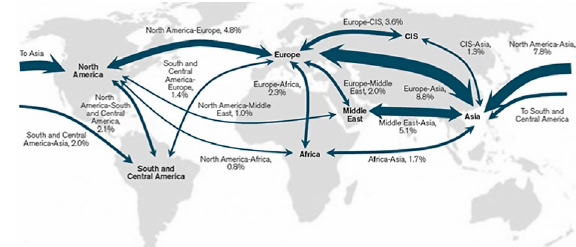
Fig. 1. Percentage share of international trade flows in